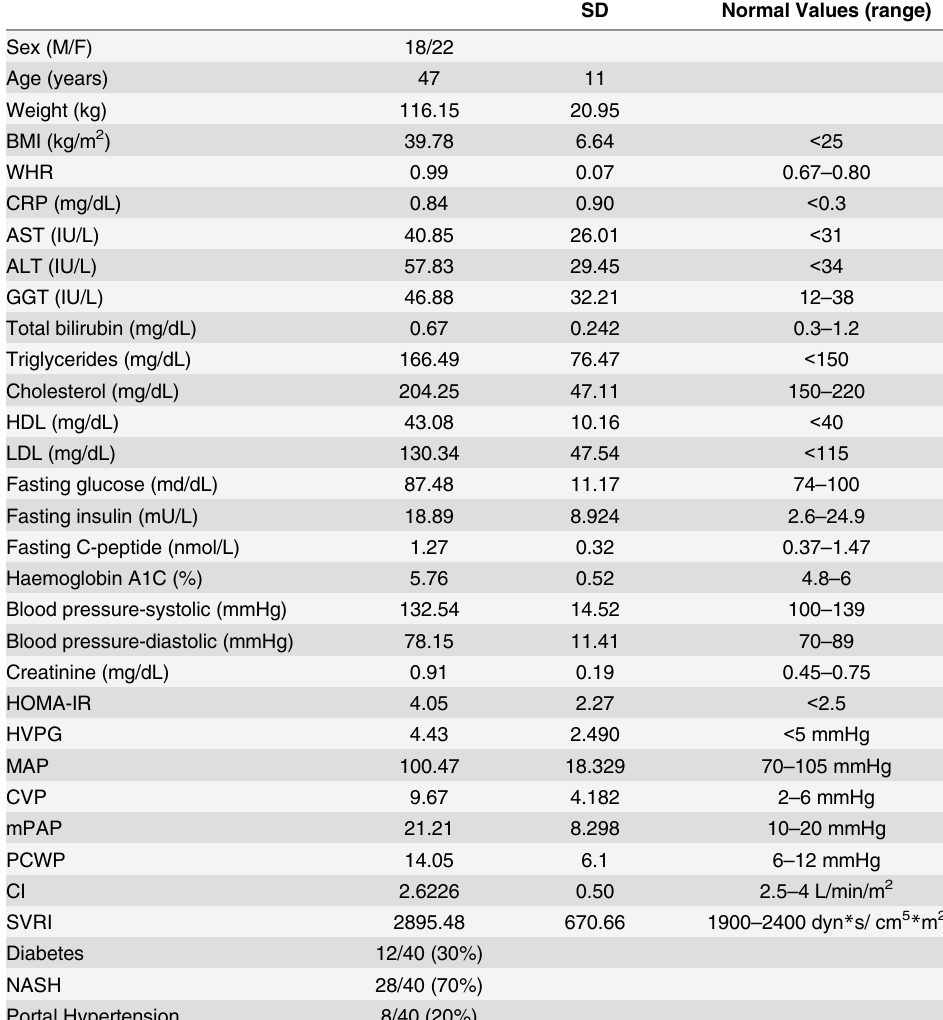
Table 1. patients ’ main characteristics.